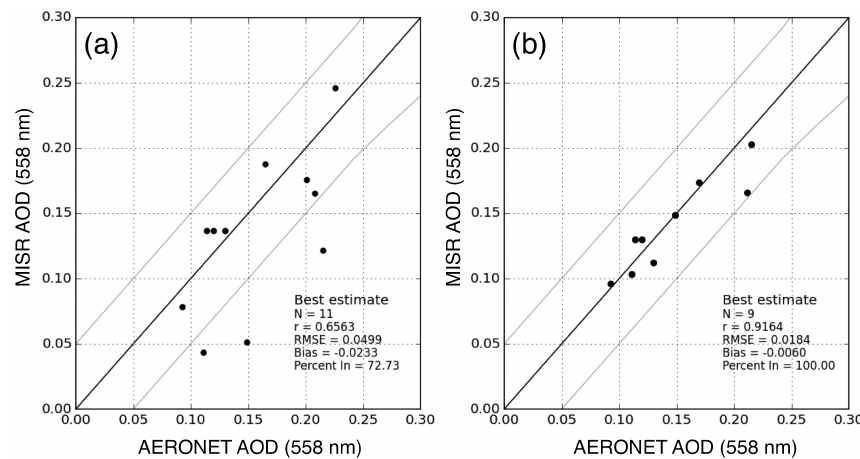
Figure 2. (a) Comparison of MISR V22 17.6km resolution AODs against AERONET-DRAGON interpolated to the MISR wavelength for 20 January 2013. (b) Comparison of the 4.4km resolution AODs against AERONET-DRAGON for the same